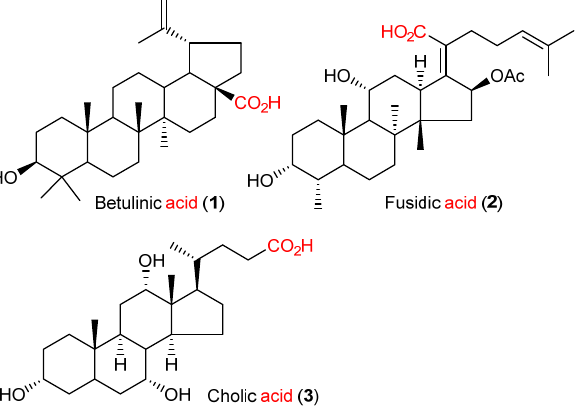
Figure 1. Structures of Betulinic acid ( 1 ), Fusidic acid ( 2 ), and Cholic acid ( 3 ).